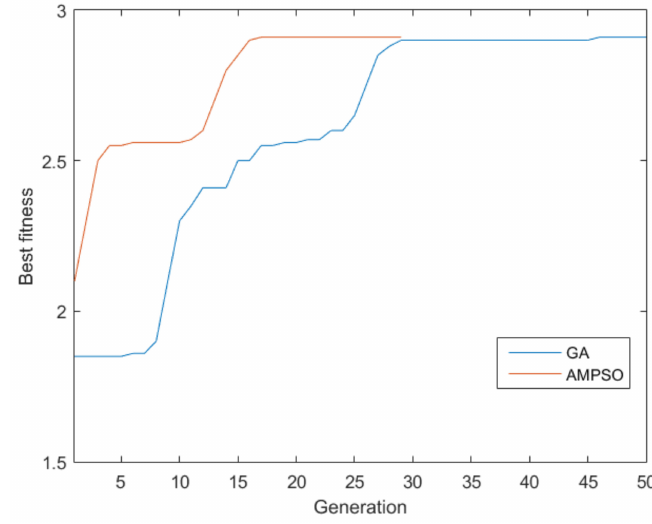
Figure 6. Overview of the stacking ensemble